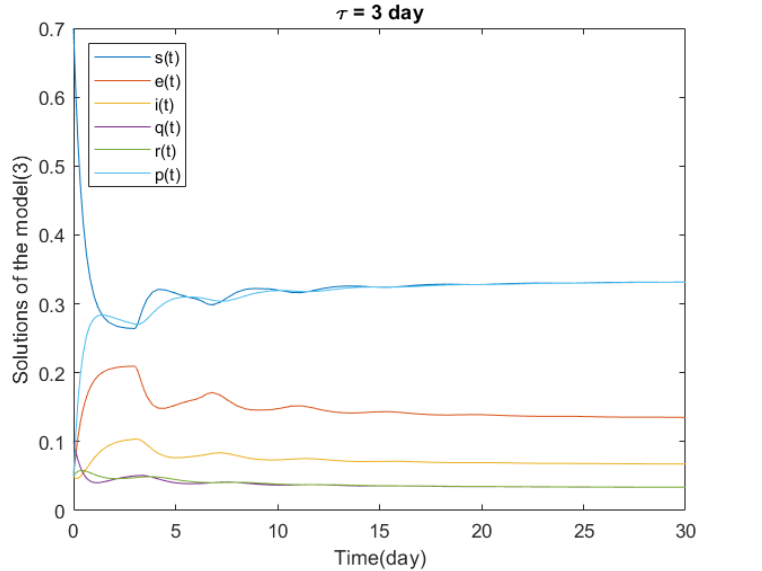
Figure 1. Dynamics of model (3) with τ = 3 days. Parameter values as in Table 1.